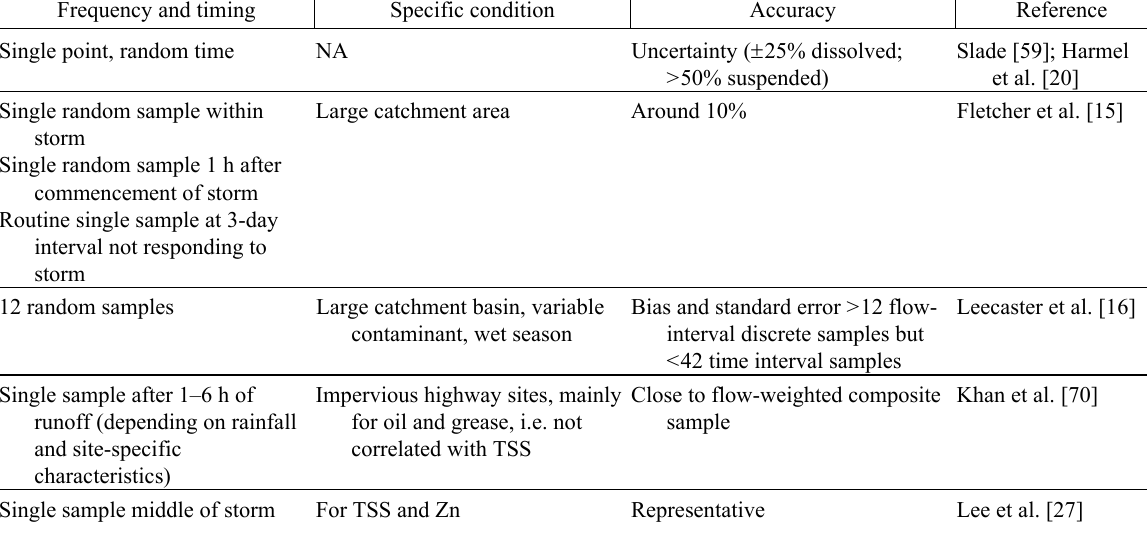
Table 4. Grab sample collection frequency and timing with relative uncertainty. NA, not analysed Frequency and